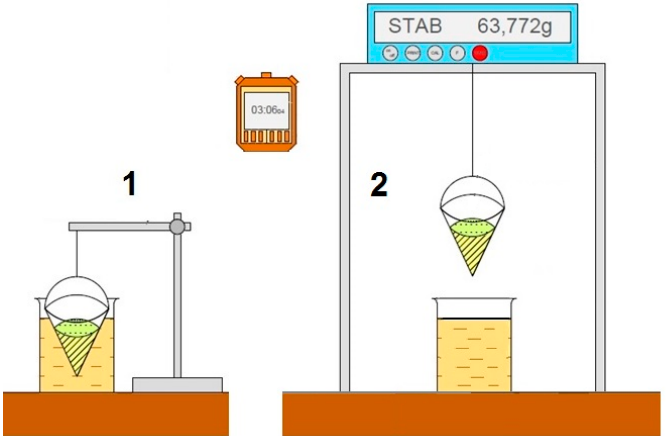
Figure 1. Scheme of test stages on the measurement stand: ( 1 ) immersion of analytical sorbent sample in the absorbed liquid, ( 2 ) dripping of absorbed liquid including control of sorbent-sorbate over time.